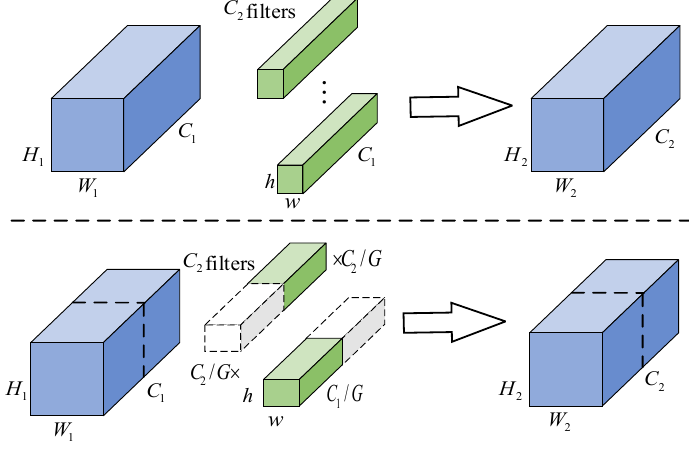
Figure 1. The structure of group convolution.